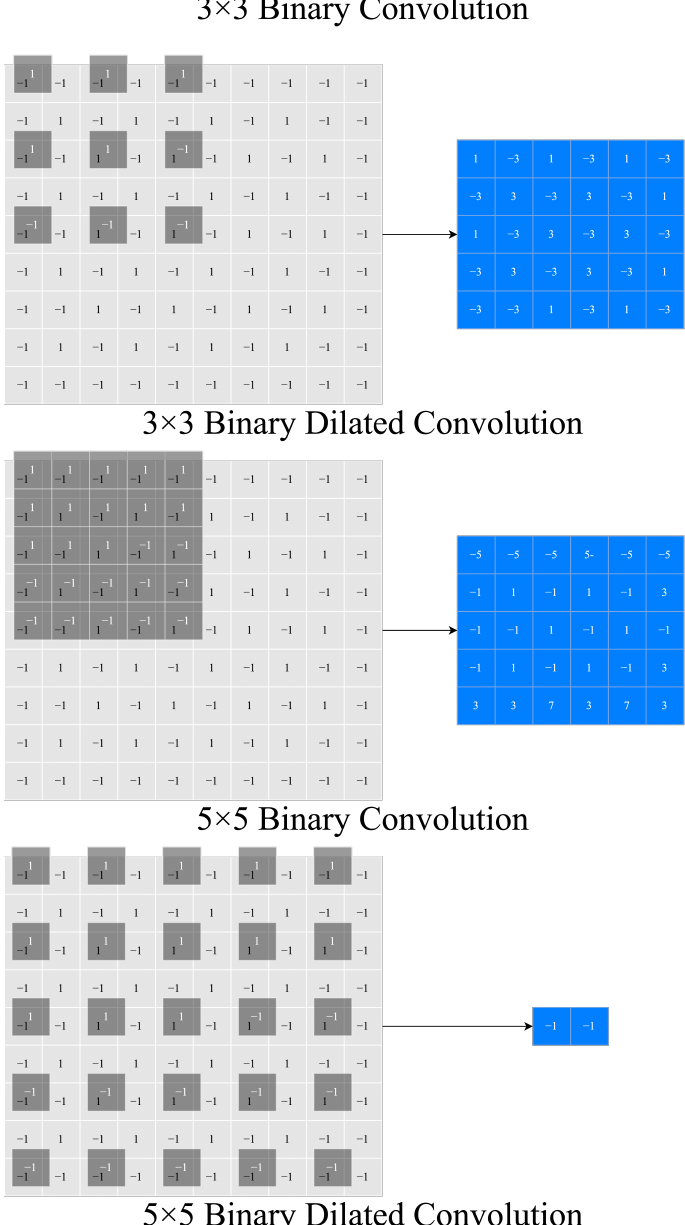
Figure 4. The demonstration of 4 different types of binary convolution in